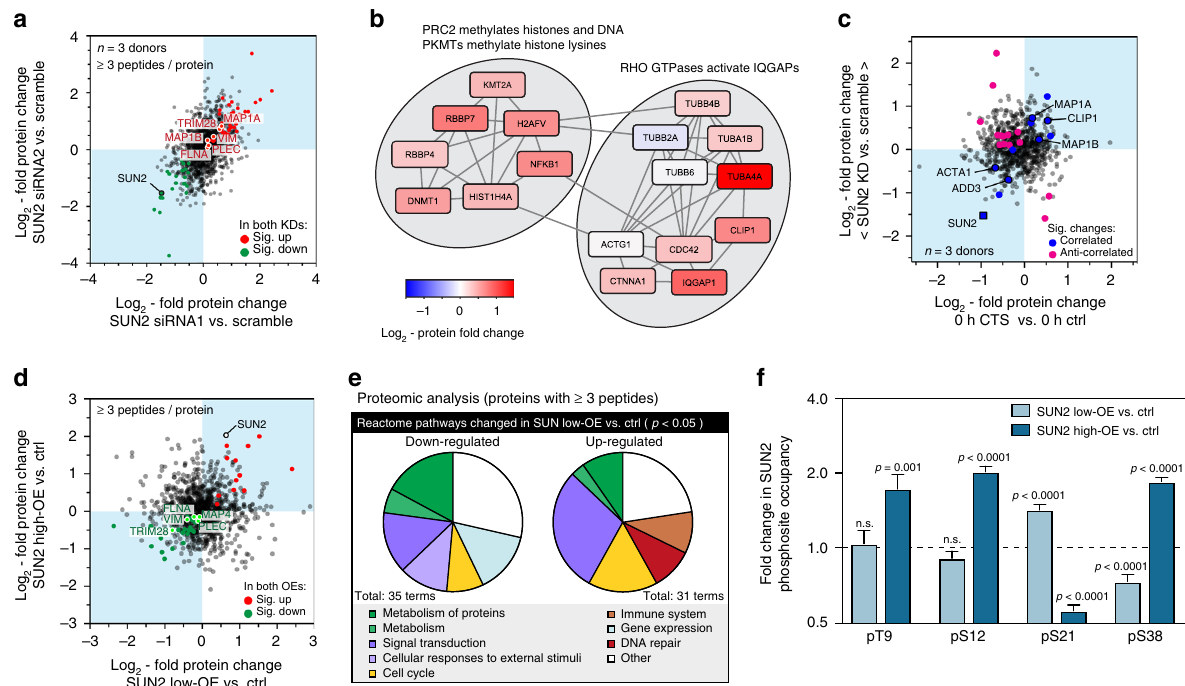
Fig. 6 Knockdown (KD) and overexpression (OE) of SUN2 affect the cellular proteome. a MS characterization of SUN2 KD on protein levels in primary hMSCs. Plot shows correlation between log 2 -fold changes to the proteome following SUN2 KD with two siRNAs, siRNA1 and siRNA2, each measured relative to scrambled controls ( n = 3 donors; see Supplementary Figs. 9a, b for histograms). Data points annotated as indicated in the legend where signi fi cant changes occurred ( p < 0.05), otherwise they are shown in gray. b Pathways identi fi ed in the Reactome database 35 as signi fi cantly affected by both SUN2 KDs, relative to scrambled controls, shown with fold changes to constitutive proteins. c Correlation between changes to protein levels following SUN2 KD (mean of both siRNA treatments, relative to scrambled controls) and immediately following CTS (1 h, 2.6 – 6.2% strain at 5 Hz relative to unstrained controls). Correlated and anti-correlated data annotated as indicated in the legend where signi fi cant changes occurred ( p < 0.05; n = 3 donors), otherwise they are shown in gray. d MS characterization of SUN2 OE in an immortalized human MSC line. Plot shows correlation between log 2 -fold changes to the proteome following SUN2 OE with two separate expression levels, low (160% of control following 3 days of DOX treatment) and high (410% of control following 4 days of DOX treatment), measured relative to vehicle-only controls ( n = 3 replicates; see Supplementary Figs. 9c, d for histograms). Data points annotated as indicated in the legend where signi fi cant changes occurred ( p < 0.05), otherwise they are shown in gray. e Analysis of Reactome pathways signi fi cantly affected at the protein level following SUN2 low-OE ( p < 0.05). Protein quanti fi cation in a – e based on ≥ 3 peptides-per- protein. f Quanti fi cation of SUN2 phosphosites following low and high OE, as characterized in d . pS21 and pS38 were signi fi cantly affected by low SUN2 OE ( p < 0.0001); high OE signi fi cantly affected pT9 ( p = 0.001), pS12, sS21, and pS38 ( p < 0.0001). n = 3 technical replicates. Data displayed as mean and